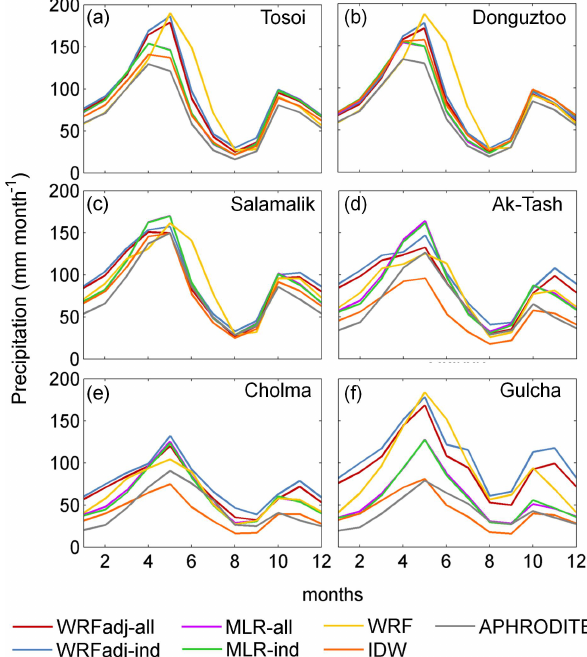
Fig. 5. Monthly subcatchment mean precipitation (1960–1990) for 6 subcatchments of the Karadarya Basin and 7 different precipita- tion